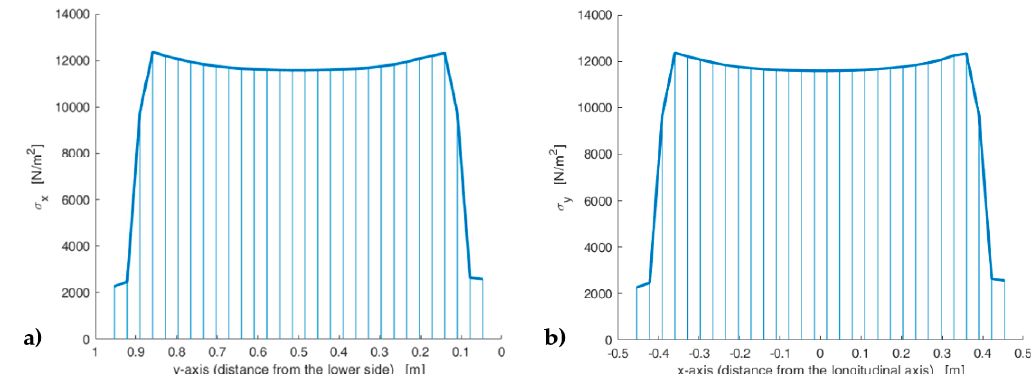
Figure 31. Axial stresses calculated at a constant distance from the constraint, along a line that passes through the center of the inclusion for: ( a ) The numerical results of the CM model and ( b ) the numerical results of the DECM model for n r = 1 and n c = n .